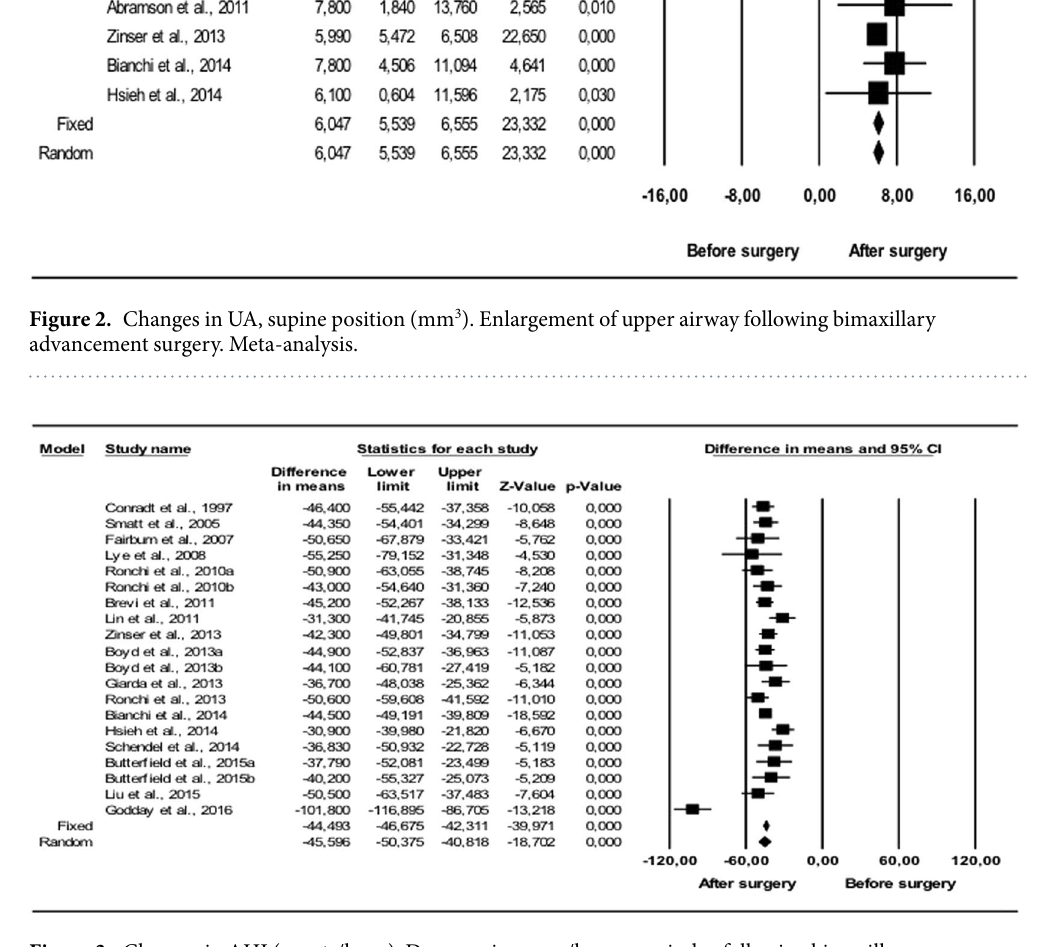
Figure 3. Changes in AHI (events/hour). Decrease in apnea/hypopnea index following bimaxillary advancement surgery.